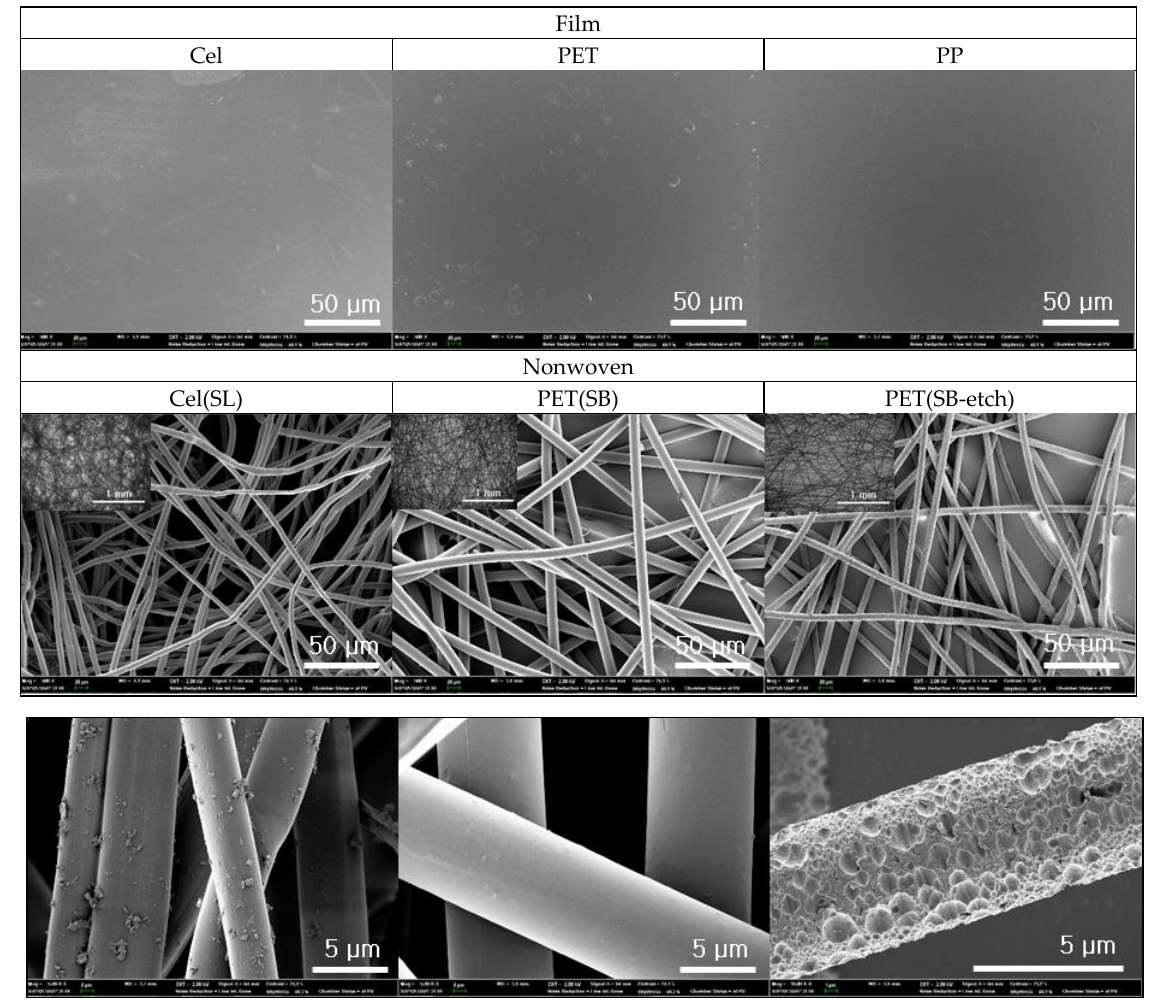
Figure 6. Scanning electron microscopy (SEM) images of surfaces. Inserts are optical microscope images with the scale bar of 1 mm.